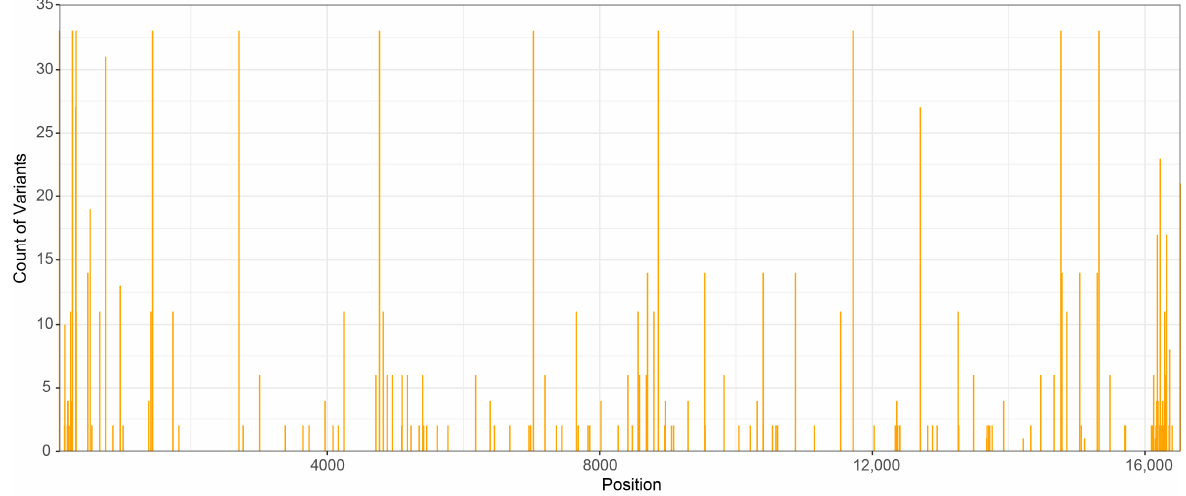
Figure 5. Variant distribution in the mtGenome. The maximum count is 33.